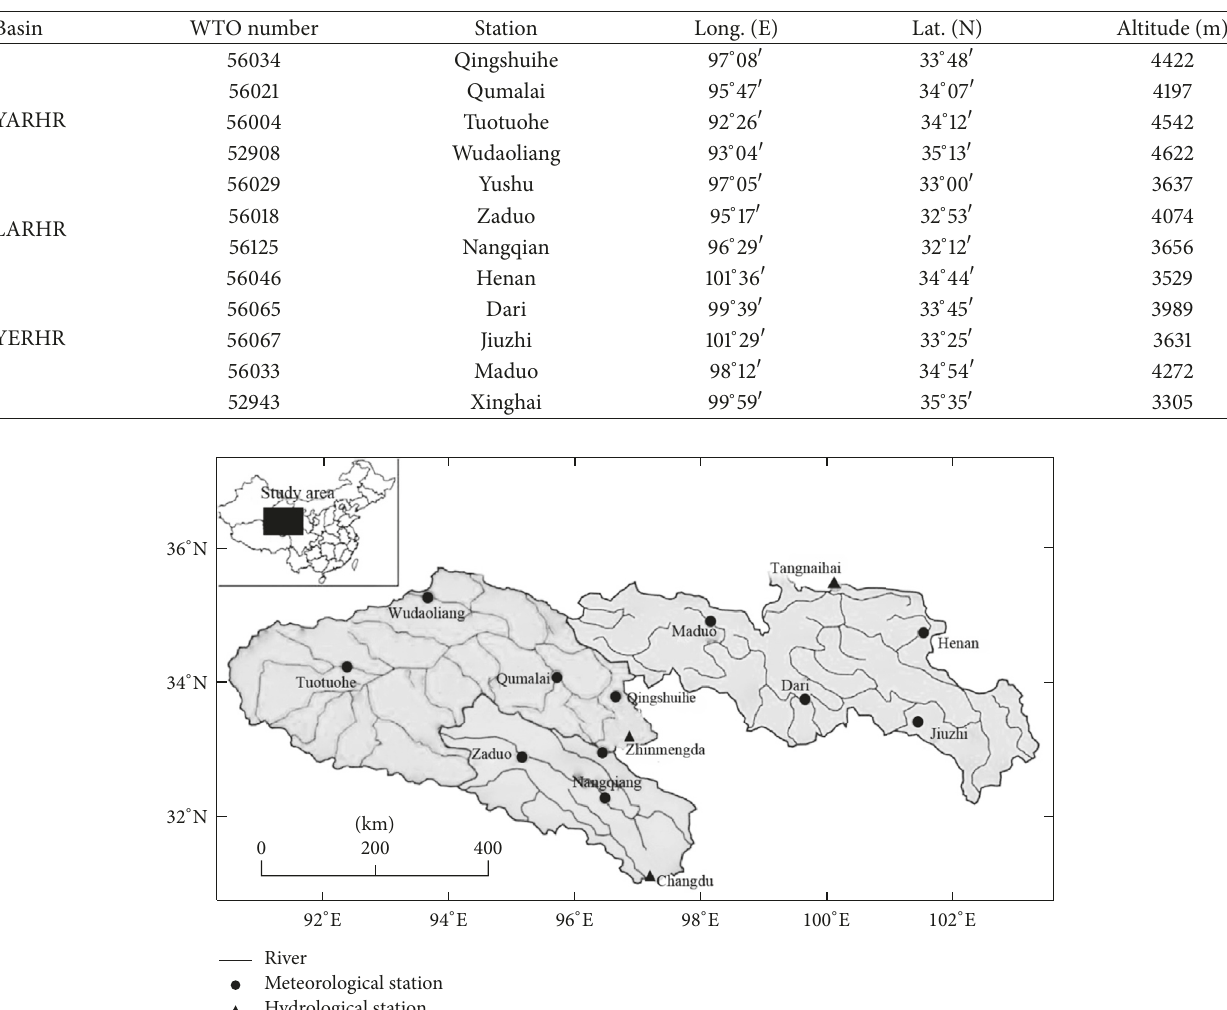
Table 1: Detailed information of the 12 meteorological stations in the TRHR.